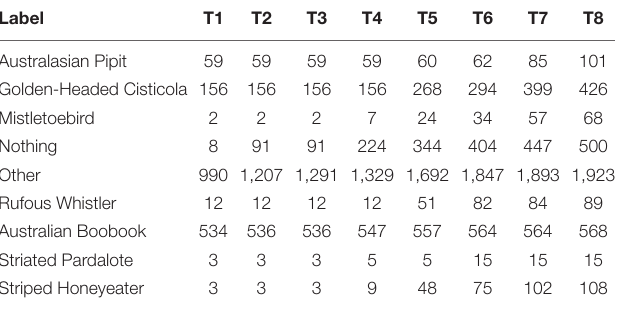
TABLE 3 | Number of examples from cotton region recordings for each class at each iteration T1 to